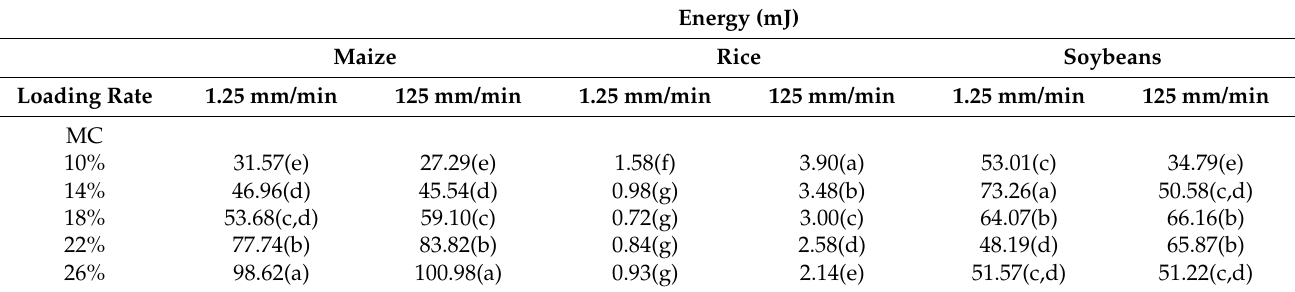
Table 6. The means comparison of energy needed to induce the breakage for interactions effect of moisture content and loading rates. Energy (mJ) Maize Rice